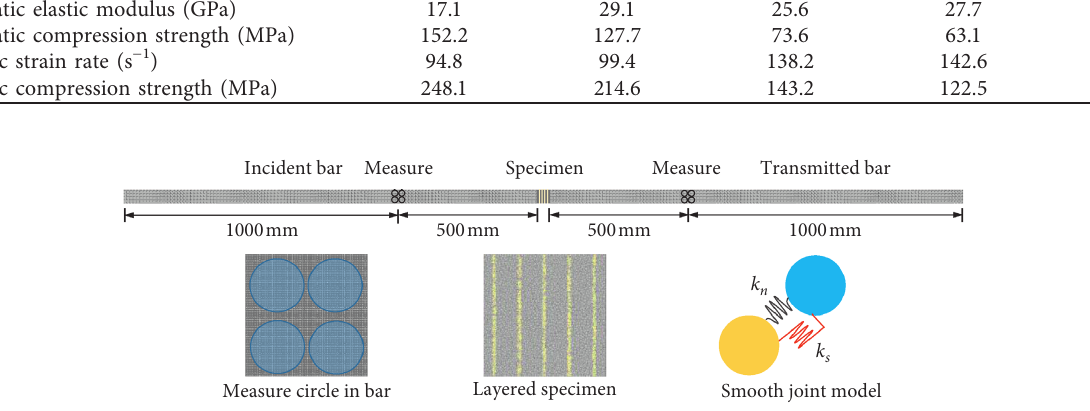
Figure 5: The SHPB numerical simulation test system.